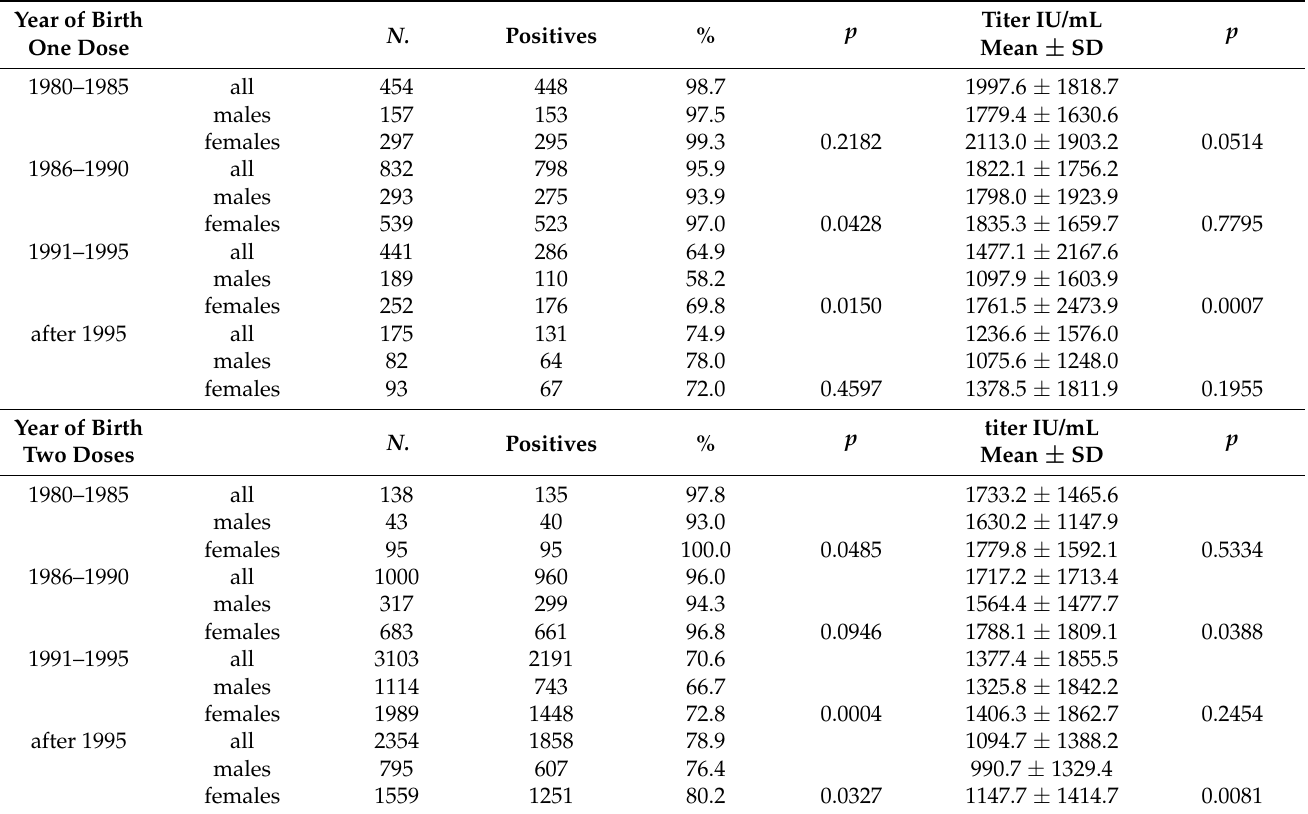
Table 5. Percentage of positive antibodies and antibody titer according to doses of vaccine and sex. The p values refer to the statistical comparison between males and